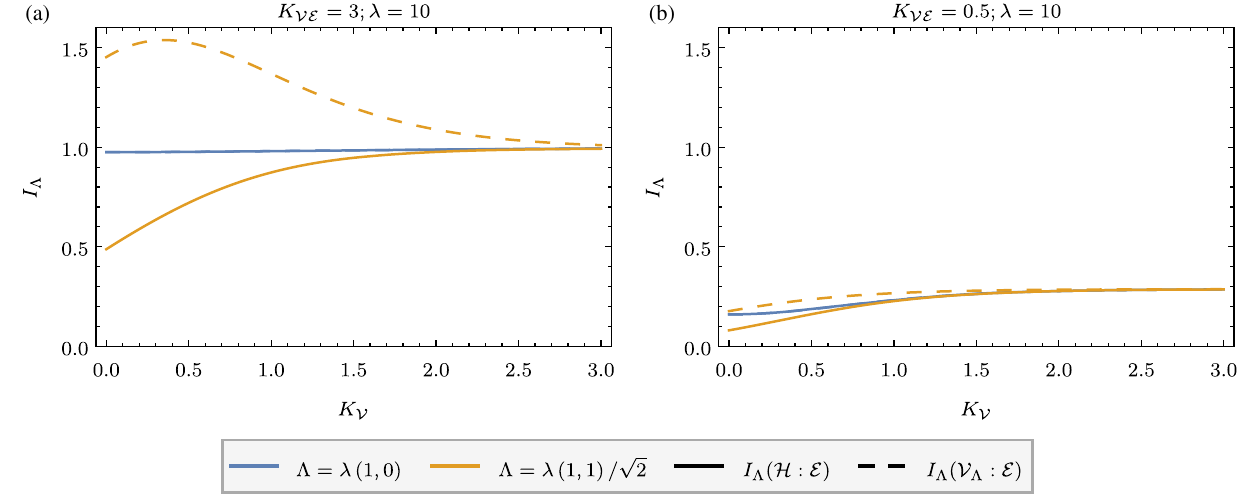
FIG. 6. The mutual information I Λ ð H ∶ E Þ and I ð V Λ ∶ E Þ for decimation (blue) and majority-rule (yellow) procedures in the 1D toy model Eq. (25). Two parameter regimes are shown: (a) strong coupling to the environment or low-temperature K VE (recall that the coupling constants contain a factor of β ¼ 1 =k B T ) and (b) weak coupling K VE ; note that the absolute value of all mutual information is lower in this limit. The solid lines differ from the dashed lines of the same color by the mismatch I ð V Λ ∶ E j H Þ (see main text). In both parameter regimes, the dashed blue line exactly coincides with the solid blue line: For the decimation procedure, the information I ð V ∶ E Þ is perfectly encoded into H . Majority rule I H ∶ E Þ is inferior to decimation, even though I ð V ∶ E Þ is significantly larger: All Λ Λ ð Λ that information is lost in encoding. The distinction between the two rules vanishes in the K V → ∞ limit when both visible spins are effectively bound into a single binary variable.